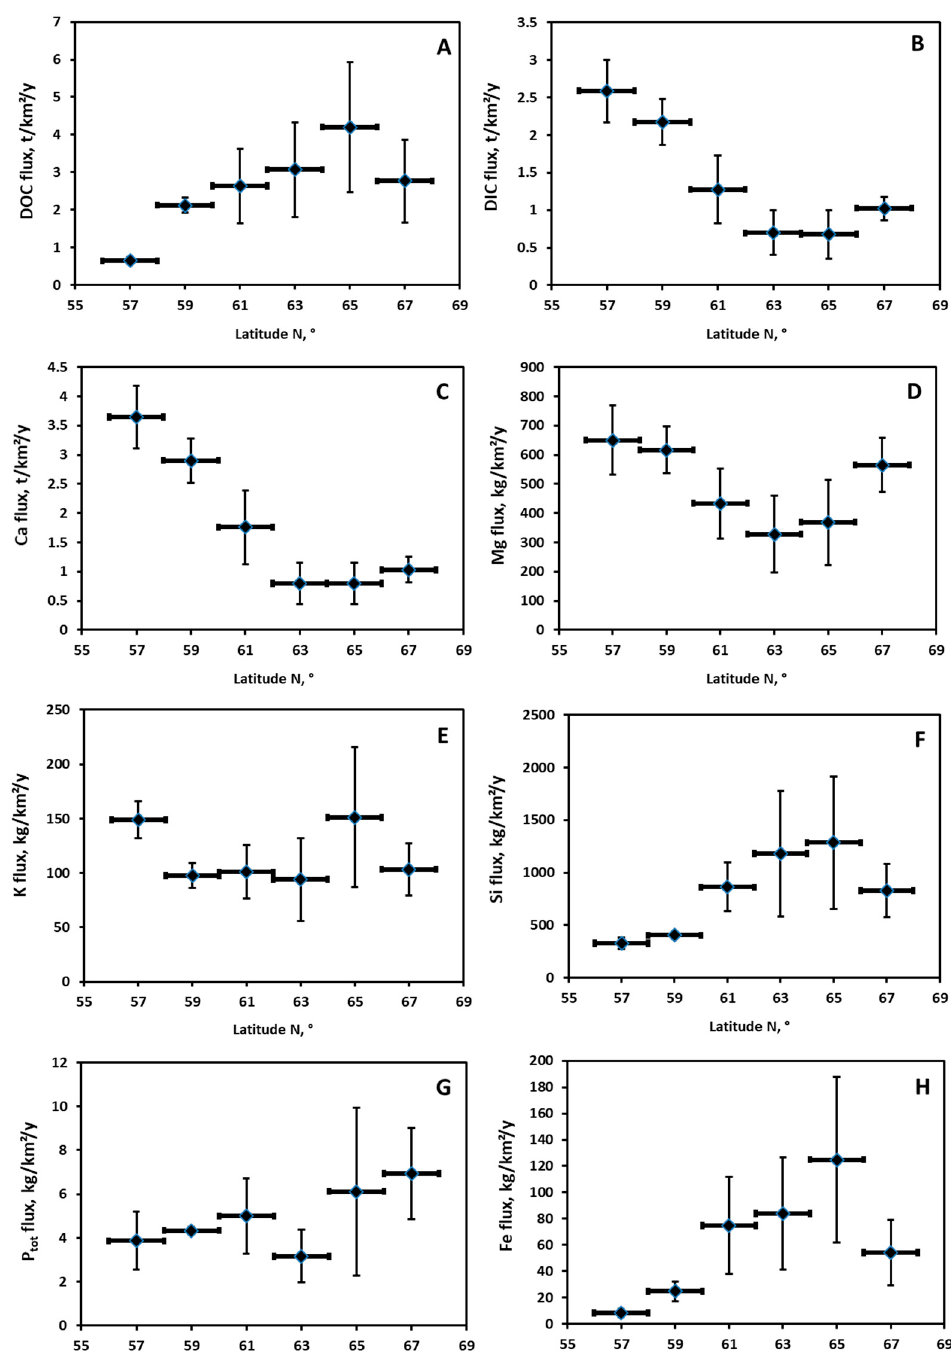
Figure 3. Yields (watershed-area normalized export fluxes) of DOC ( A ), DIC ( B ), Ca ( C ), Mg ( D ), K ( E ), Si ( F ), P tot ( G ) and Fe ( H ) during May-October 2016 in 33 WSL rivers across the latitudinal gradient. The vertical uncertainties represent the 2 s.d. of several rivers belonging to the same latitudinal belt. Thick horizontal bars represent the 2 ◦ latitudinal belts. The year is represented by open-water period (May to October), neglecting winter (November to April), when small rivers freeze solid in the north.